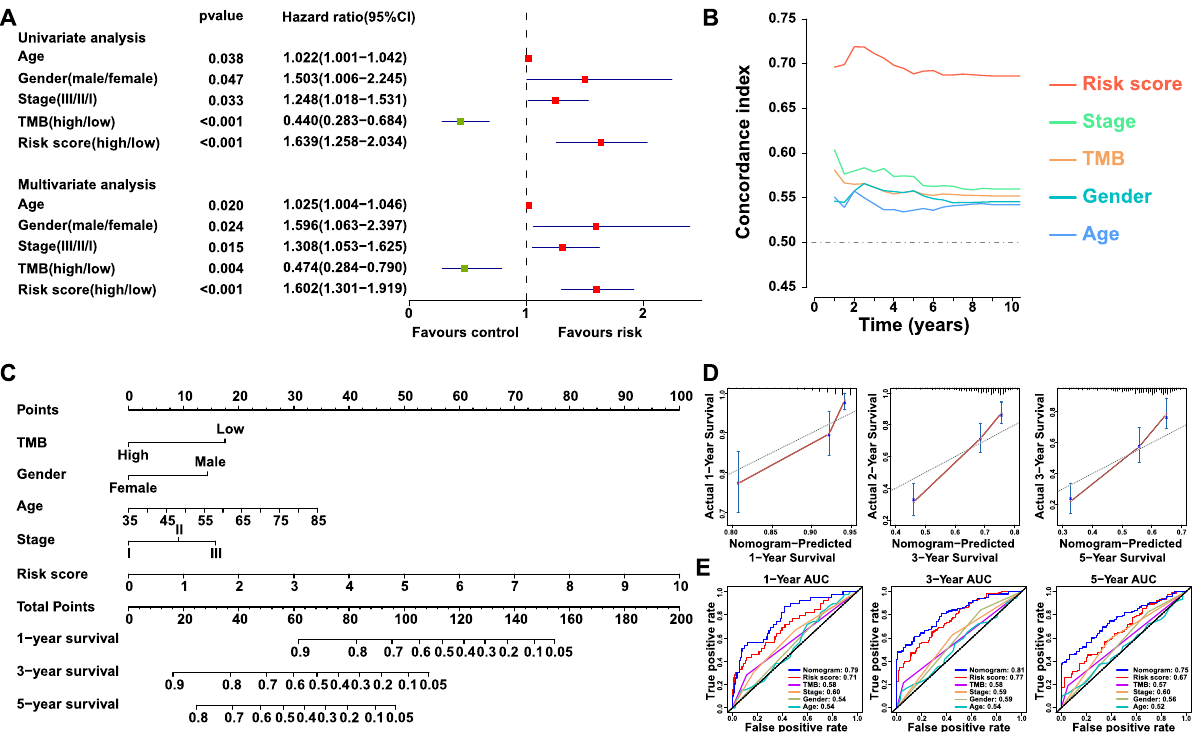
Figure 5. Nomogram development and validation based on the IPM. ( A ) Univariate and multivariate Cox regression analysis of the prognostic value of clinical features and the IPM in TCGA LUSC cohort. Red squares indicate adverse outcomes, and green squares indicate favorable outcomes. ( B ) C-index showing the prognostic performance of clinical features and the IPM. ( C ) Nomogram integrating clinical characteristics with the IPM for predicting 1-,3-, 5-year survival probability. ( D ) Calibration plot for internal validation of the nomogram. ( E ) Time-dependent ROC curves for evaluating the predictive efficacy of the